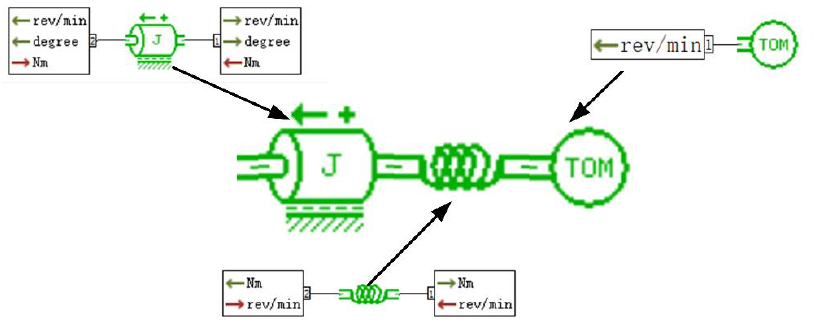
Figure 4. Dynamic model.